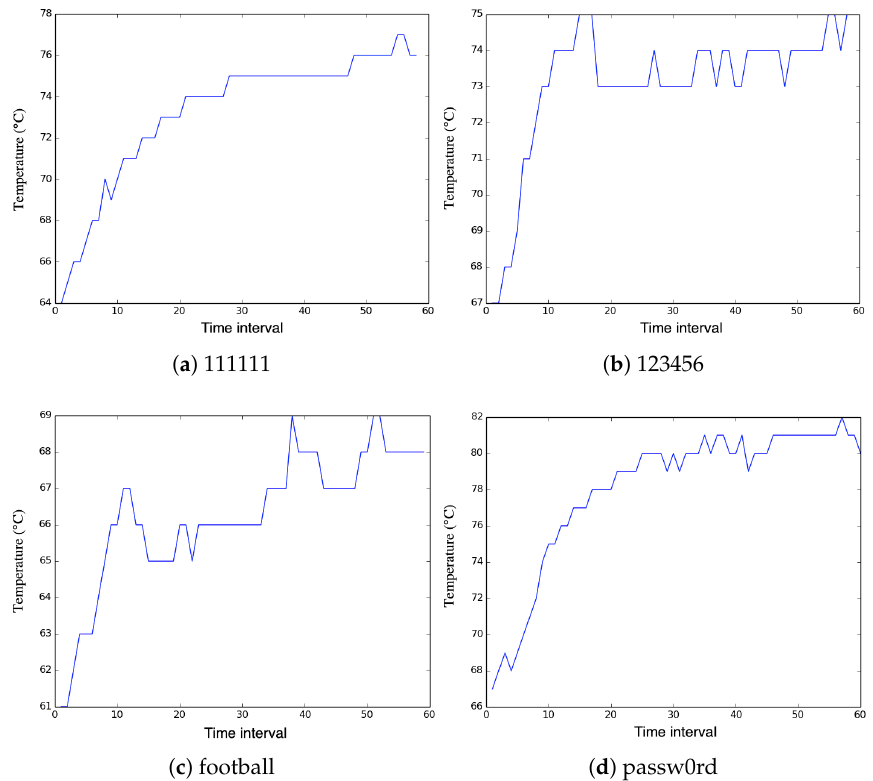
Figure 3. Graphical representation of thermal behavior (time interval vs temperature in °C) of encryption operation using the following passwords: 111111 , 123456 , football , and passw0rd .